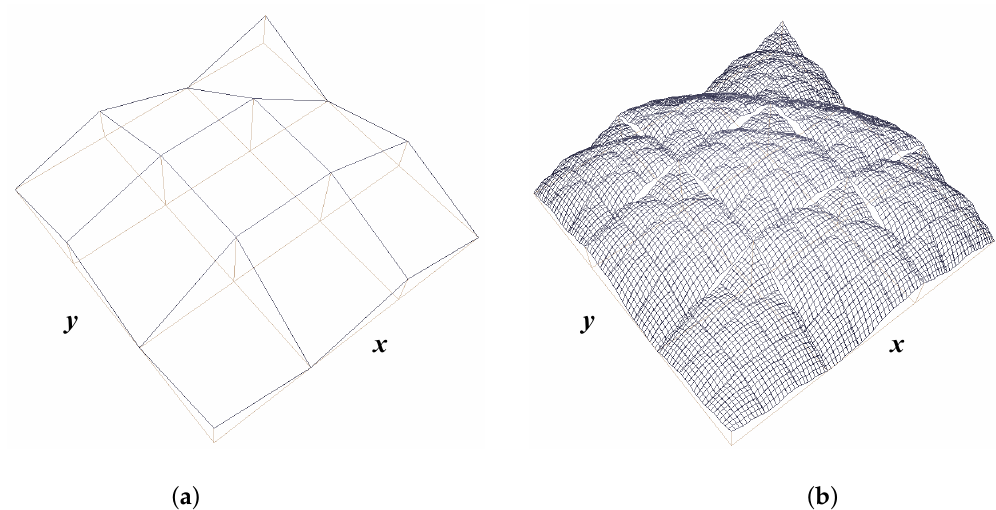
Figure 8. ( a ) The surface constructed with the original set of data. ( b ) The fractal surface